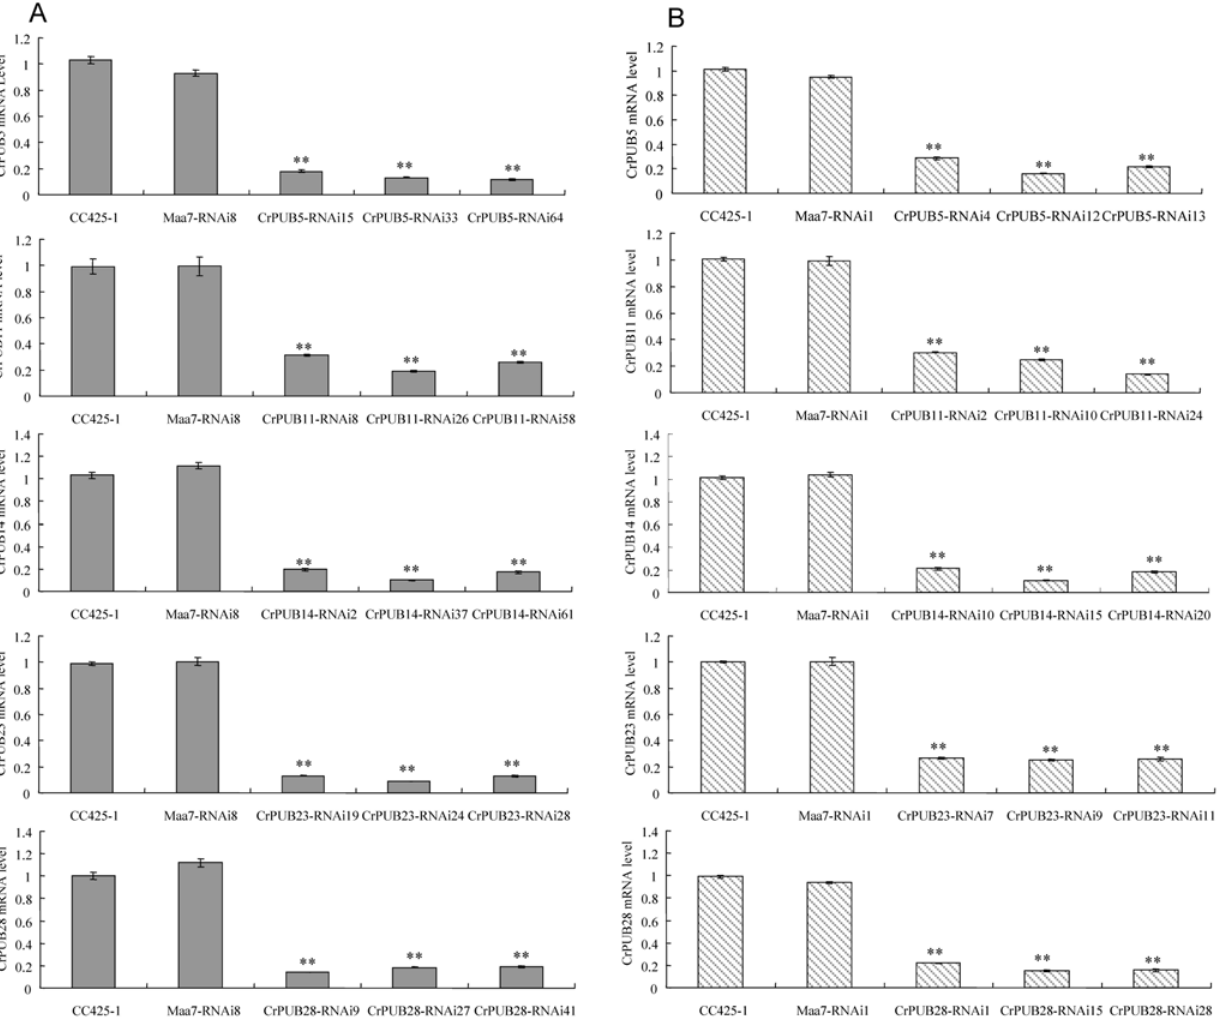
Fig 8. Comparison of the mRNA abundance of CrPUB genes in RNAi transgenic strains and wild type C . reinhardtii CC425. (A) CrPUB gene transcript levels in RNAi lines containing the constructs harboring the fragments amplified using primers set A as the dsRNA. (B) CrPUB gene transcript levels in RNAi lines containing the constructs harboring the fragments amplified using primers set B as the dsRNA. The dsRNA was obtained from RT-PCR amplification and subcloned into pMaa7IR/XIR. The constructs were transformed into CC425 using the glass bead method. In total, at least 30 resistant strains were selected in each case. CrPUB gene transcript levels were determined by real-time RT-PCR, with the 18S rRNA gene used as an internal control. The height of each column presents the relative gene expression compared with that in wild type CC425 strains. The examined gene transcription levels in empty-vector transformants are shown as Maa7-RNAi. The gene abundances in CrPUB5, CrPUB11, CrPUB14, CrPUB23 and CrPUB28 RNAi lines are shown from the top to bottom, respectively. Significant differences were observed between the RNAi lines and the controls ( ** P < 0.01 Duncan ’ s post-test). The data are presented as the means of three replicates from one experiment. The error bars represent